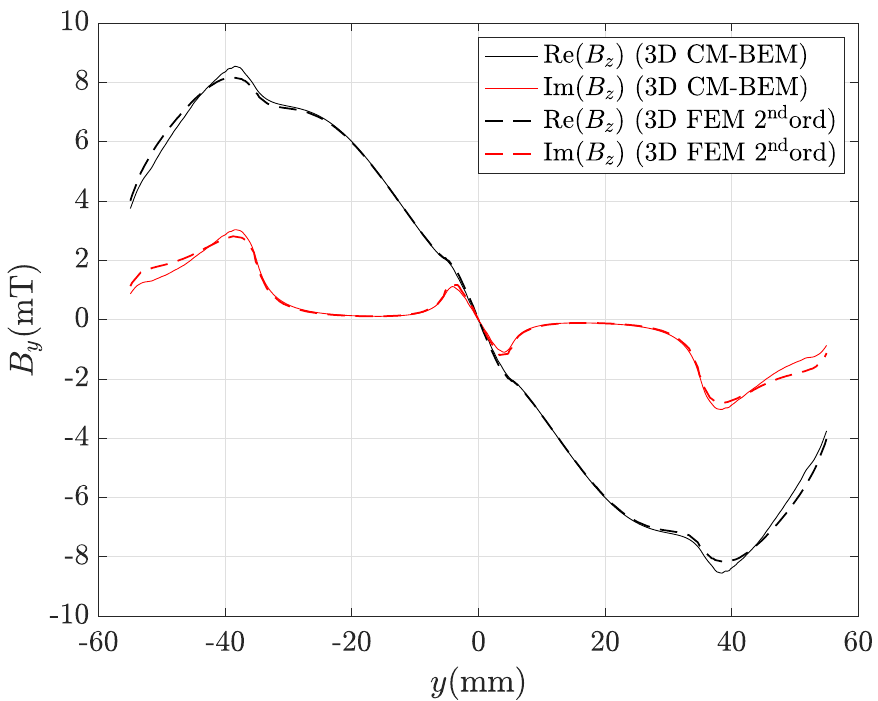
Figure 15. Real and imaginary parts of the magnetic flux density radial component B y along line AB in Figure 8 computed by the hybrid method (ACA matrix compression) with the finest mesh (435,213 tets): CM-BEM is the straight line, second ord. 3D FEM (reference) is the dashed